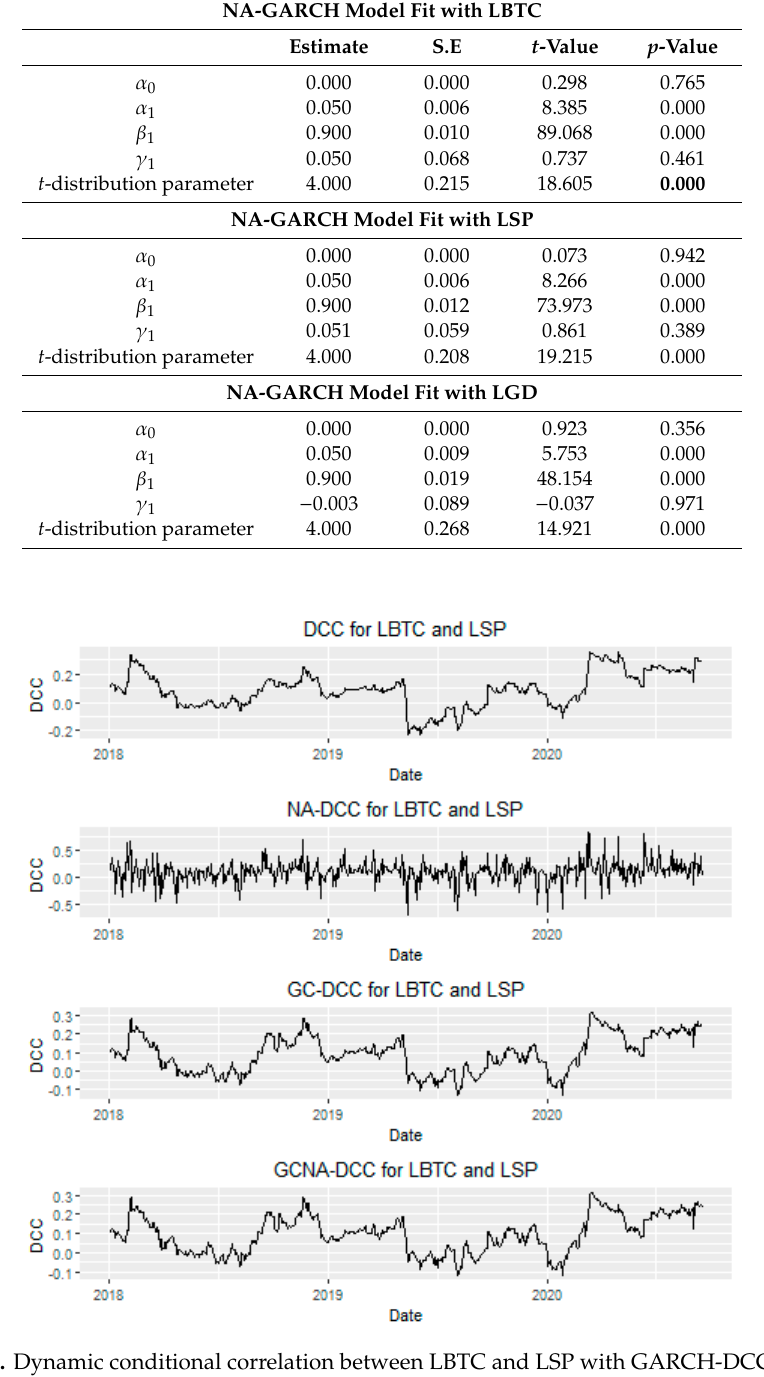
Figure 3. Dynamic conditional correlation between LBTC and LSP with GARCH-DCC (DCC), Nonlinear Asymmetric GARCH-DCC (NA-DCC), Gaussian copula-based GARCH-DCC (GC-DCC), and Gaussian copula-based Nonlinear Asymmetric GARCH-DCC (GCNA-DCC).